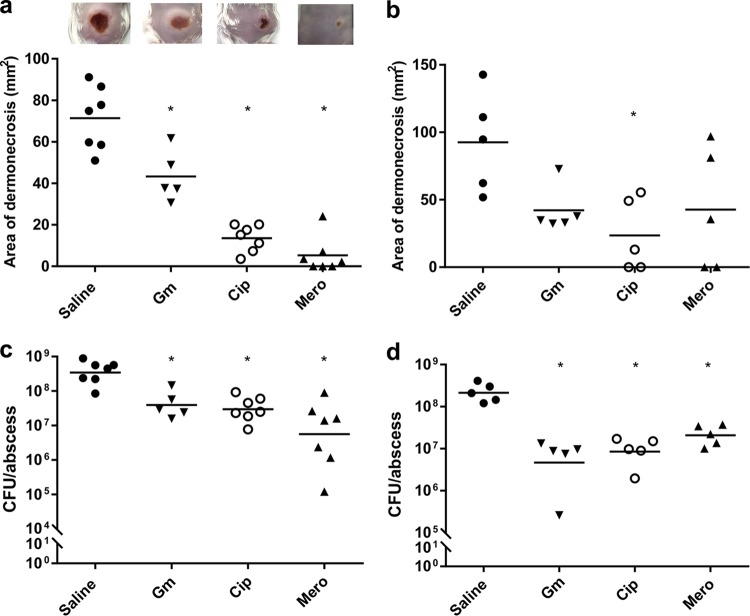
Therapeutic treatment of mouse cutaneous abscesses. CD-1 mice were infected with 5 × 107 CFU P. aeruginosa LESB58 and treated with saline solution, gentamicin (Gm; 8 mg/kg; 200 µg/abscess), ciprofloxacin (Cip; 0.4 mg/kg; 10 µg/abscess), or meropenem (Mero; 0.4 mg/kg; 10 µg/abscess). Lesion sizes and CFU counts were determined 3 days postinfection. The experiment was repeated at least twice. (a and b) Dermonecrosis measurements. (c and d) CFU counts/abscess. (a and c) Single antibiotic application 1 h post-bacterial infection. (b and d) Multiple antibiotic applications were performed starting from 1 h post-bacterial infection and subsequently every day for another 48 h. *, significant difference from saline solution-treated mice (one-way ANOVA; P < 0.01).